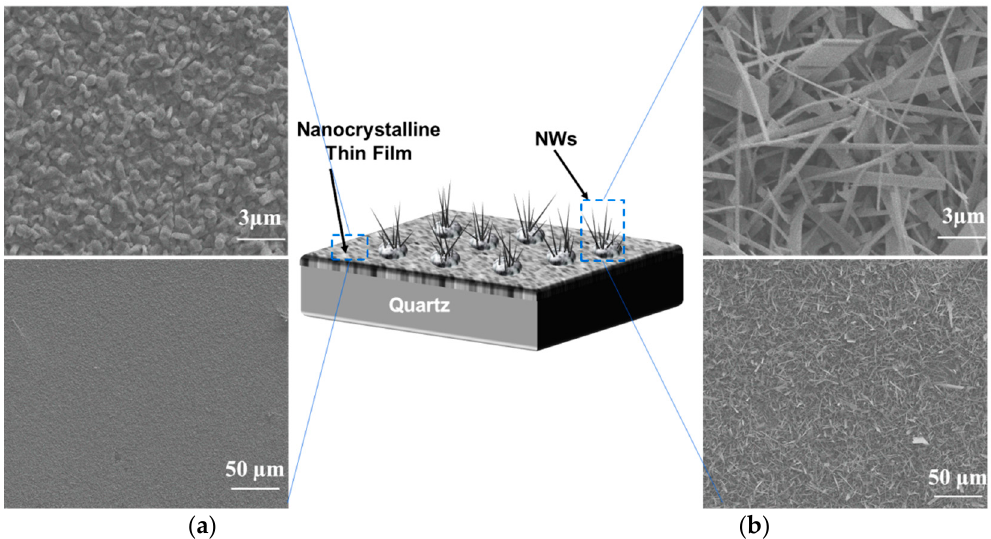
Figure 3. Scanning electron microscopy (SEM) images of 5 nm Ag-coated and uncoated areas acquired in the regions indicated in the illustration (middle). ( a ) Thin film. ( b ) nanowires.